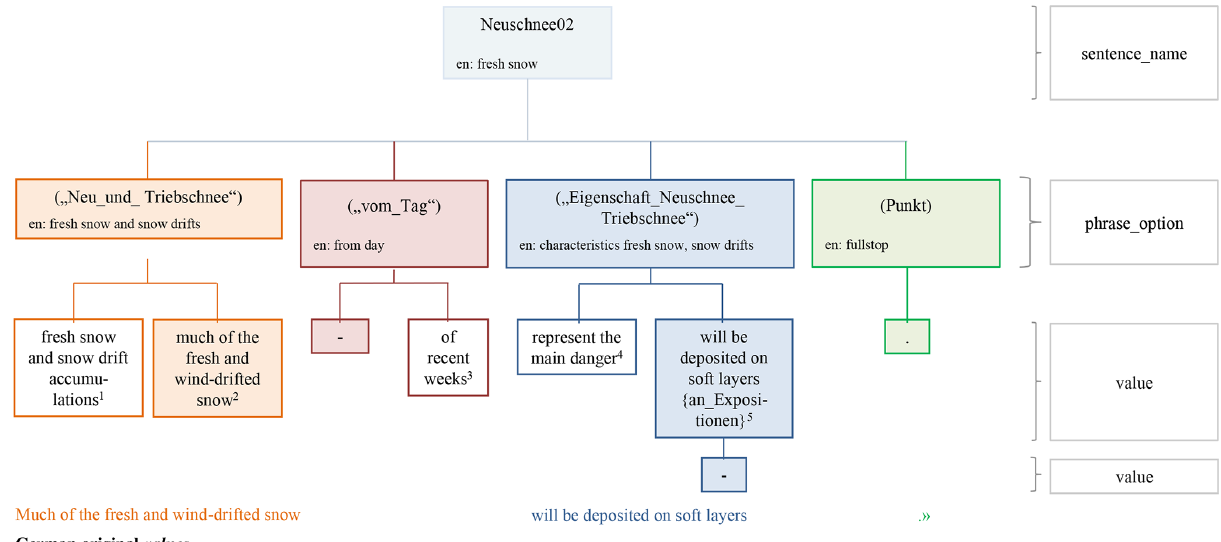
Figure 2. Structure of the catalogue of phrases. A sentence consists of phrase_options . These must be filled with values . In this example, the sentence labeled Neuschnee02 is selected. This sentence contains four phrase_options, each providing a set of values (text modules). In this example, only two of the possible values are shown. The operational language in the Swiss catalogue of phrases is